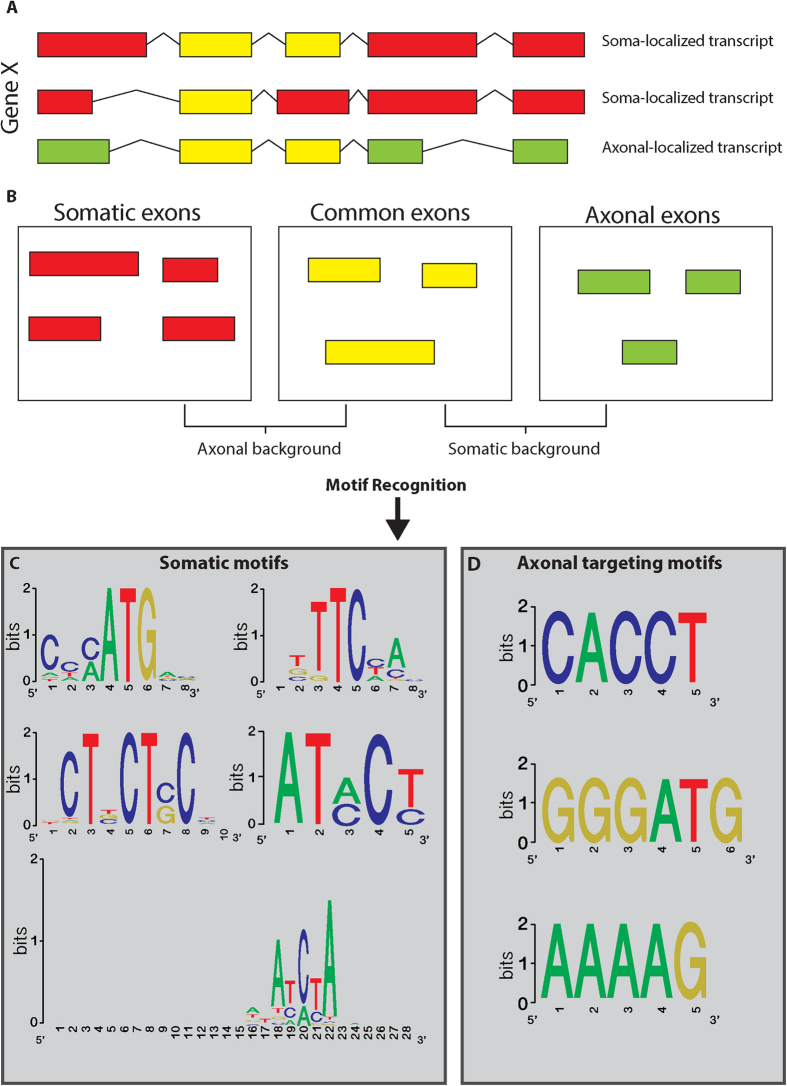
Axonal and somatic localization signals.(A,B) Schematic representation of the analytical process. Differentially expressed genes with differentially expressed transcripts having at least one transcript expressed in the soma and one in axons were studied. Exons were sorted according to site of expression and used either in the target set or in the background. Target sets were analyzed compared to the background using an online PSSM tool to reveal targeting motifs68 (C) Soma motifs. (D) Axon targeting motifs.